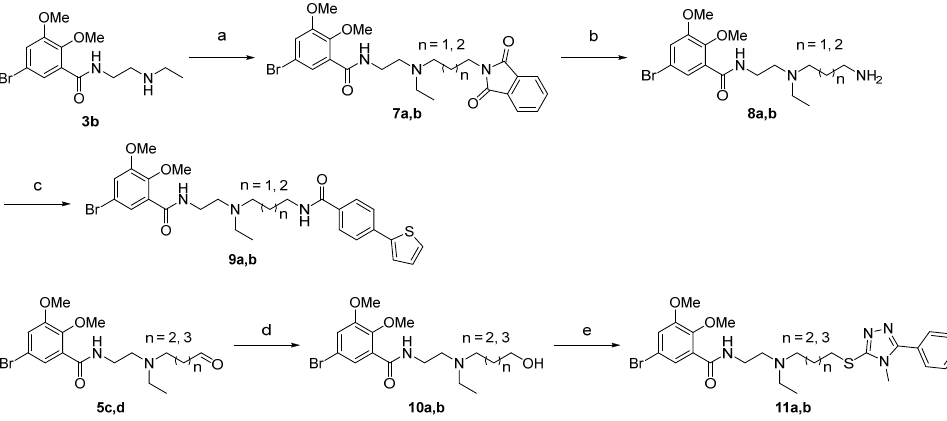
Scheme 2. Synthesis of 9a , b or 11a , b for the SBS interactions. Reagents and conditions: (a) N -(3- bromopropyl)phthalimide or N -(4-bromobutyl)phthalimide, K 2 CO 3 , DMF, 65 °C, 16 h; (b)